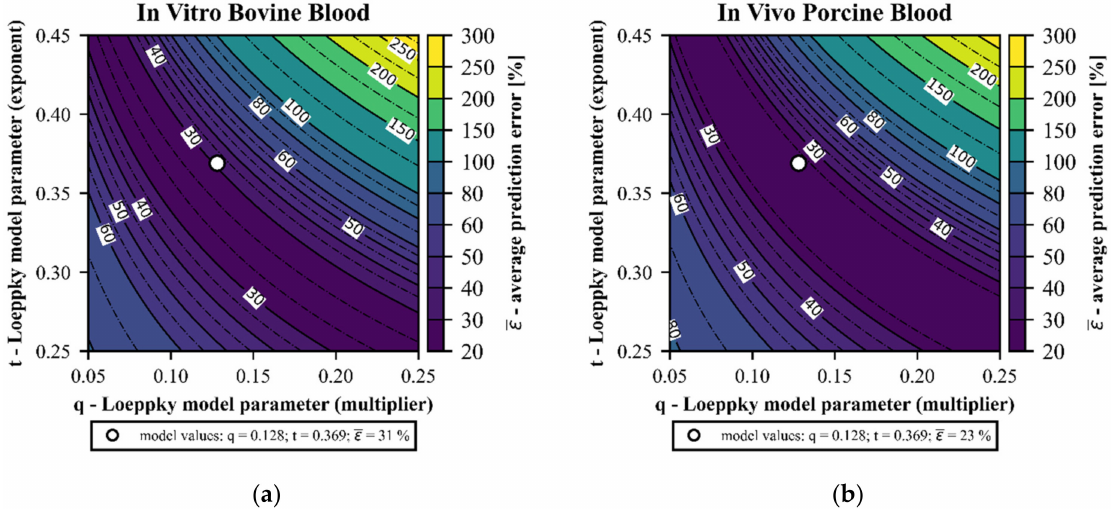
Figure 13. Average prediction error ( ε ) of the Loeppky model as a function of the two empirical model parameters q and t: ( a ) in vitro bovine blood trials and ( b ) in vivo porcine blood